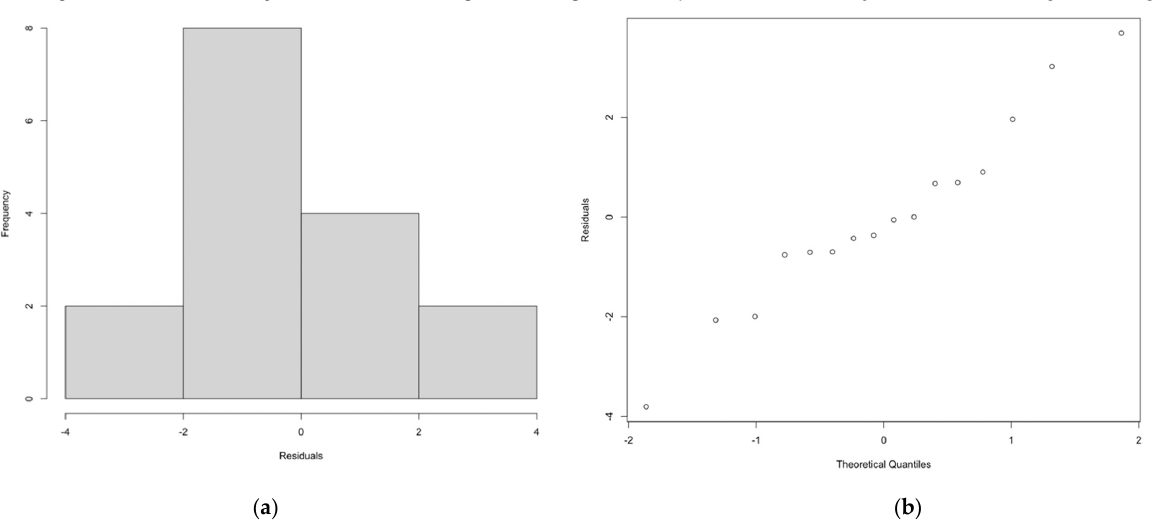
Figure A3. The ( a ) histogram and ( b ) normal Q–Q plot of GEE residuals, informed by normalised shedding ( Δ Ct) and social change management periods. Histograms and normal Q–Q plots for social change, between and within herd moves, were all identical as they incorporated the same data set. The histogram and Q–Q plot exhibited an approximately normal distribution via a bell-shaped curve and alignment of data along the diagonal line, respectively. There was no evidence to suggest the distributions were not normal as determined by a Shapiro–Wilk test (social change p = 0.8, between herd moves p = 0.8, within herd moves p = 0.8).